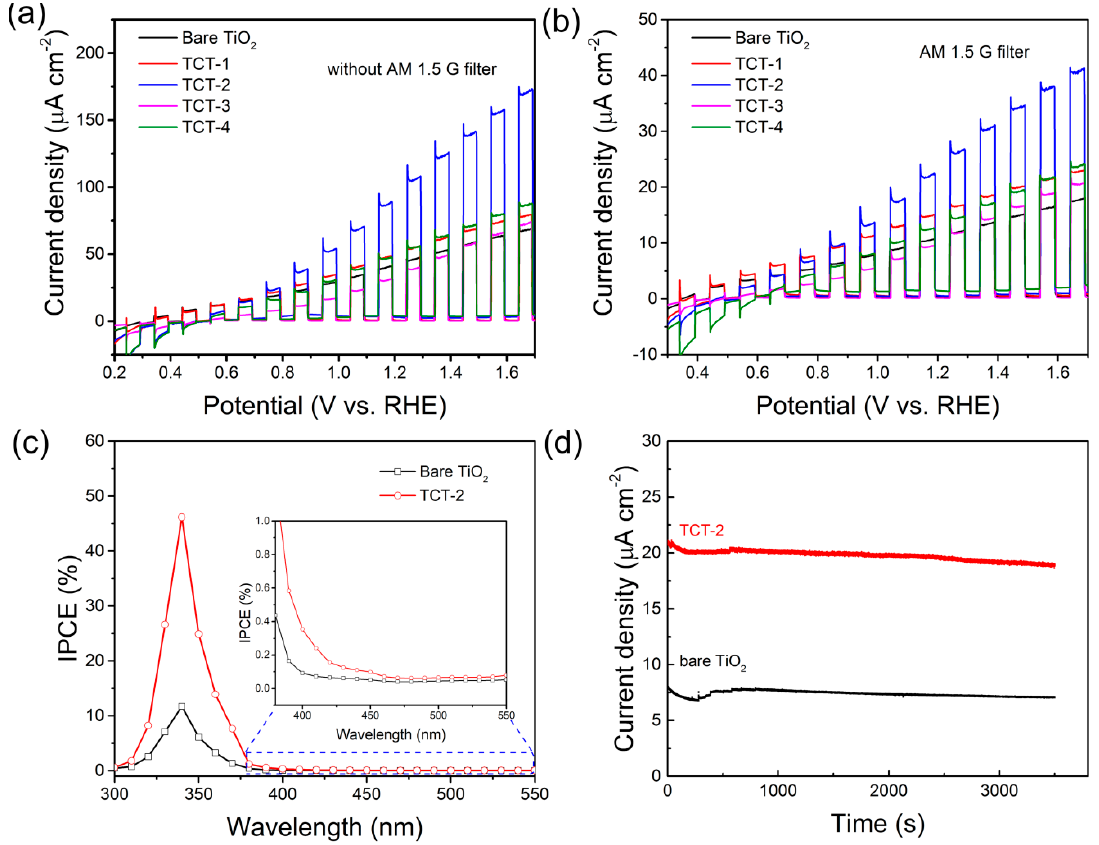
Figure 7. Linear scanning J-V curves of all samples in 0.5 M Na 2 SO 4 with AM 1.5G filter ( a ) and without filter ( b ); ( c ) IPCE curves measured at 1.23 V (vs. RHE); and ( d ) steady state photocurrent at